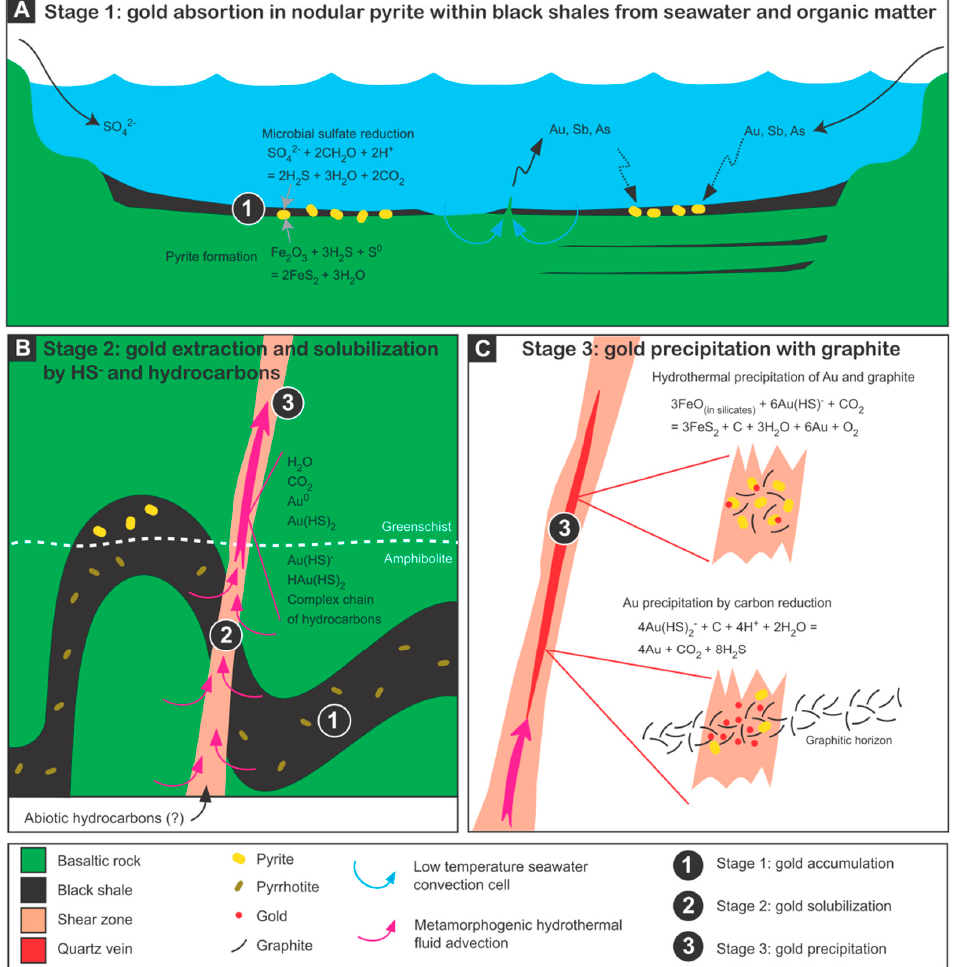
Figure 3. Schematic representation of the role of carbonaceous organic matter in the formation of orogenic gold deposits in three stages. ( A ) Source stage when gold in seawater accumulates in primary pyrites from the bacterial reduction of sulfate in organic material-rich sediments; modified from Rickard et al. [62]. ( B ) Mobilization stage when gold is solubilized by hydrocarbon-metal com- plexes and as colloidal gold nanoparticles for hydrothermal transport along faults following basin inversion and related tectonic shortening and metamorphism. Hydrocarbons are generated by ther- mal maturation of black shales or from abiotic deep contributions. ( C ) Precipitation stage when gold is co-precipitated with graphite from hydrocarbon-rich fluids or when gold is precipitated by car- bon-rich reducing horizons.